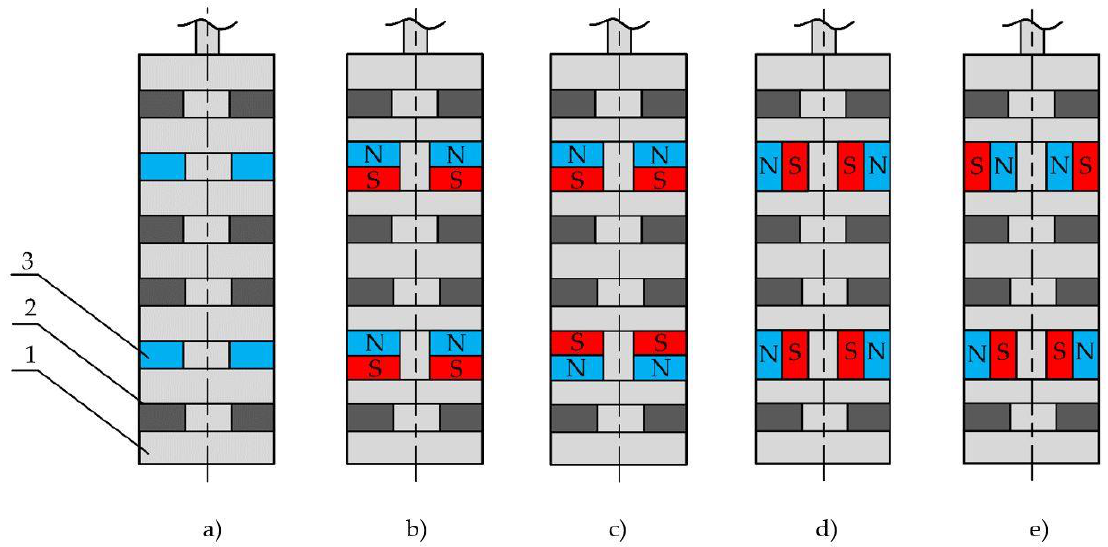
Figure 5. Versions of the magnet orientation in a slider (drawings are not to scale): ( a ) Overall geometry and dimensions of a slider. 1—non-magnetic material; 2—MRF insert; 3—magnet. ( b ) Unidirectional axial. ( c ) Counter-directional axial. ( d ) Unipolar radial. ( e ) Differential radial.